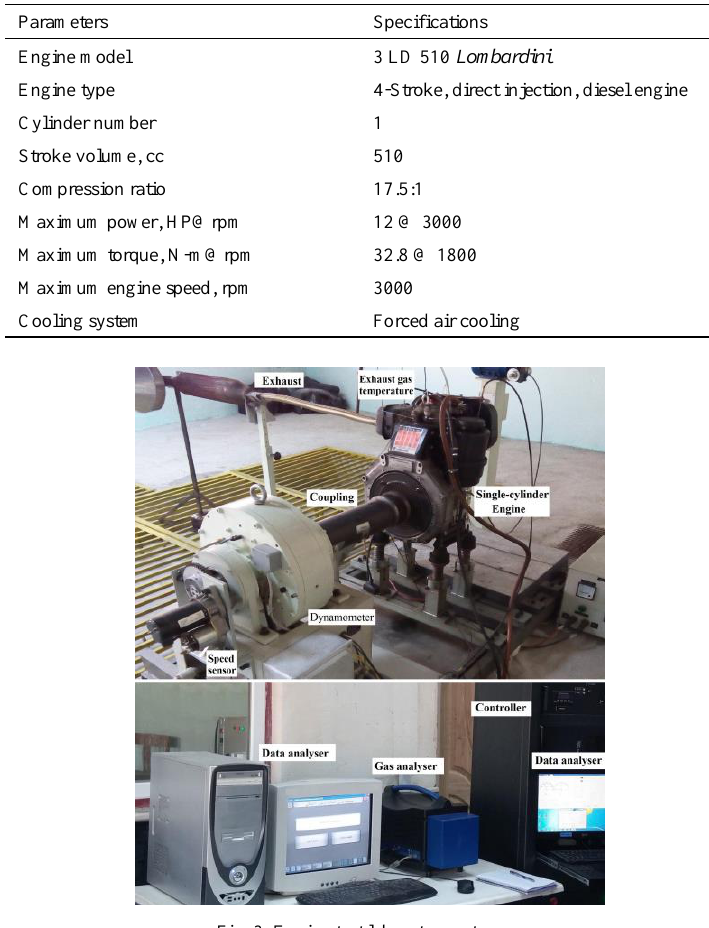
Fig. 3. Engine test laboratory